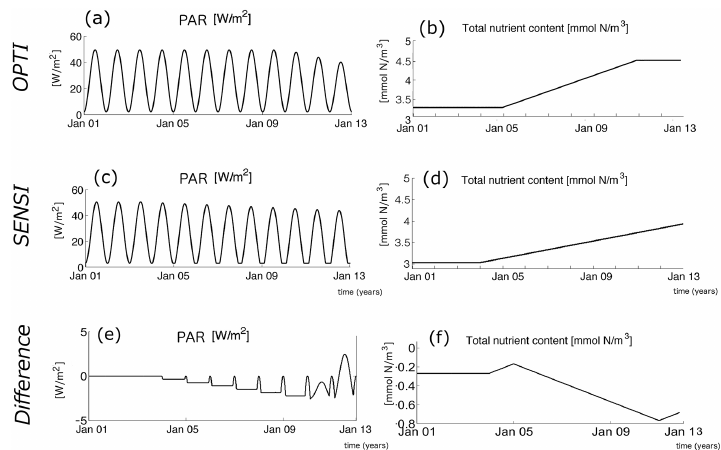
Figure 1. (a–b) Forcing OPTI: (a) shows the photosynthetically available radiation (PAR) averaged over 24h and the surface mixed layer and (b) the total fixed nitrogen in the system. (c–d) like (a–b) but for SENSI, (e) PAR difference, SENSI – OPTI. (f) Difference in total nutrient content, SENSI –